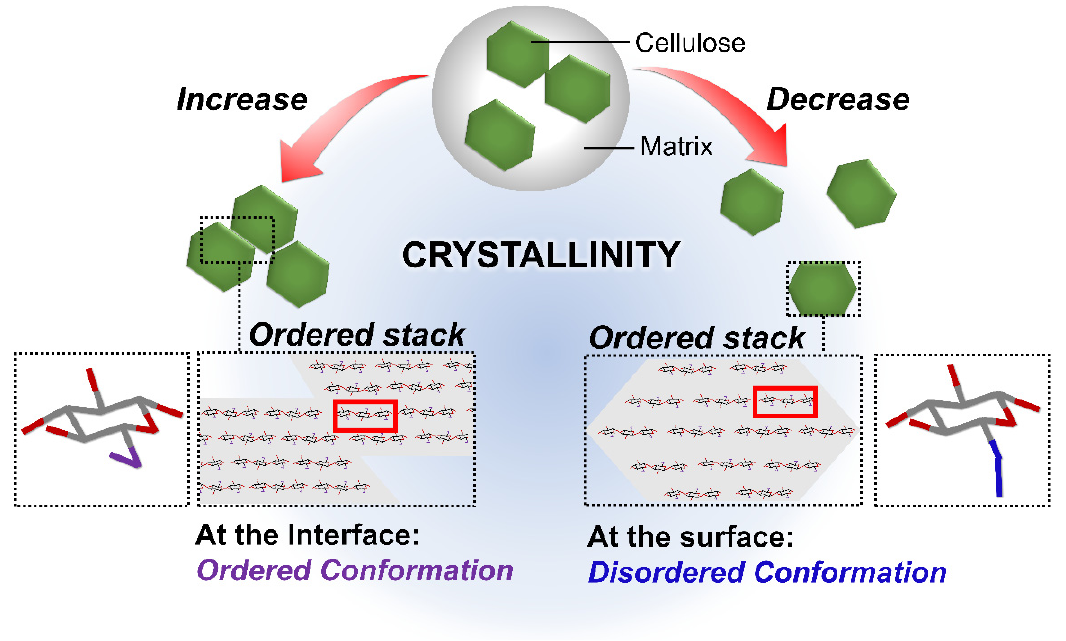
Figure 4. Mechanism of dispersion-induced disordering of the interfacial molecules between bundled microfibrils in a wood cellulosic structure that affect the crystallinity. Adapted from [47].